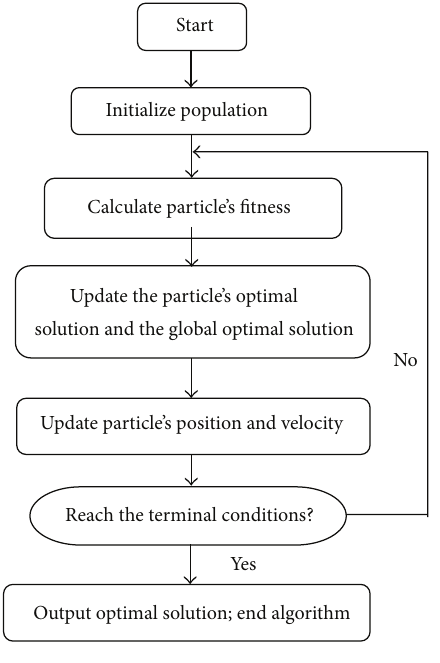
Figure 1: Flowchart of